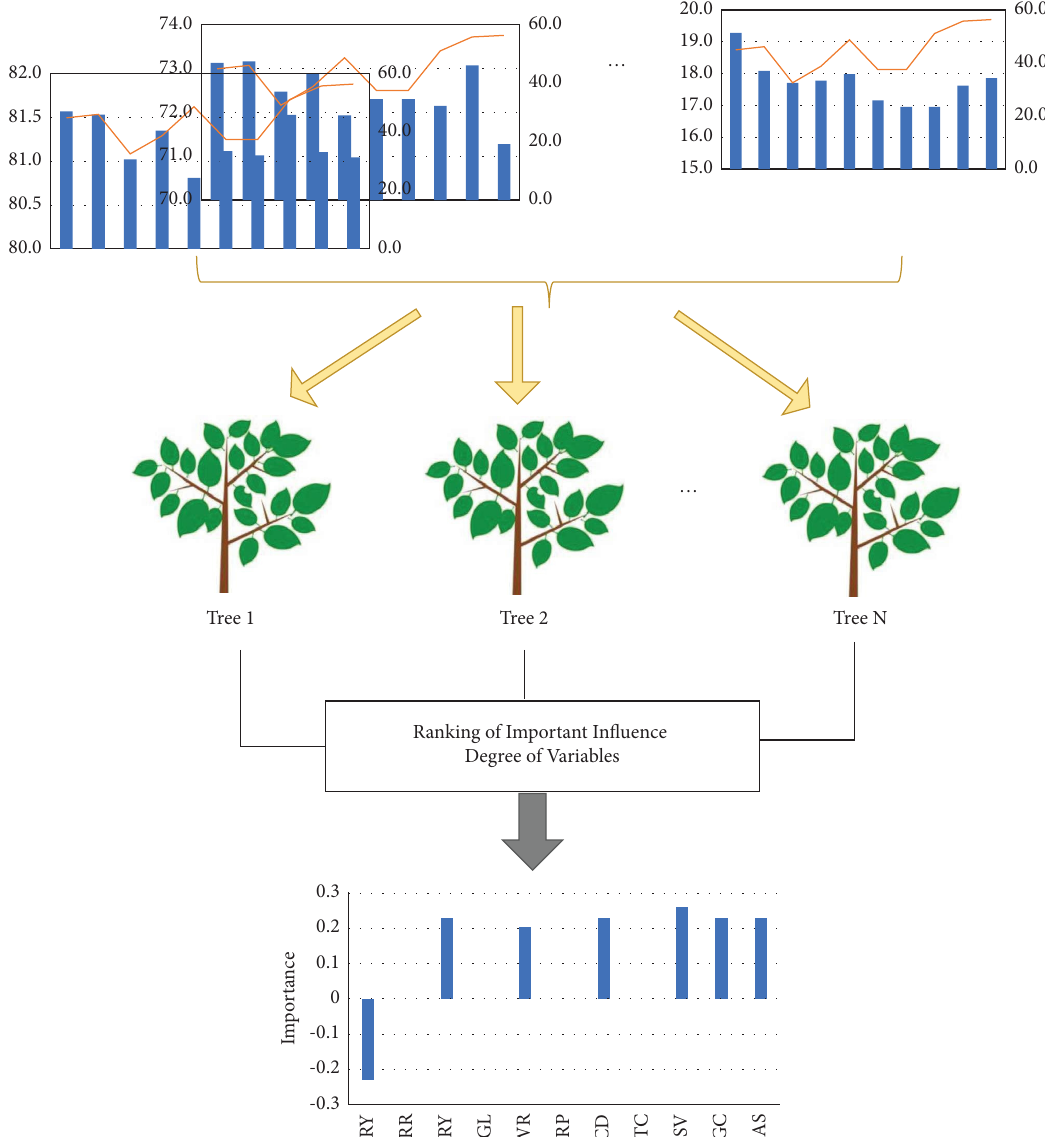
Figure 5: Schematic diagram of a random forest for continuous monitoring and analysis of rice